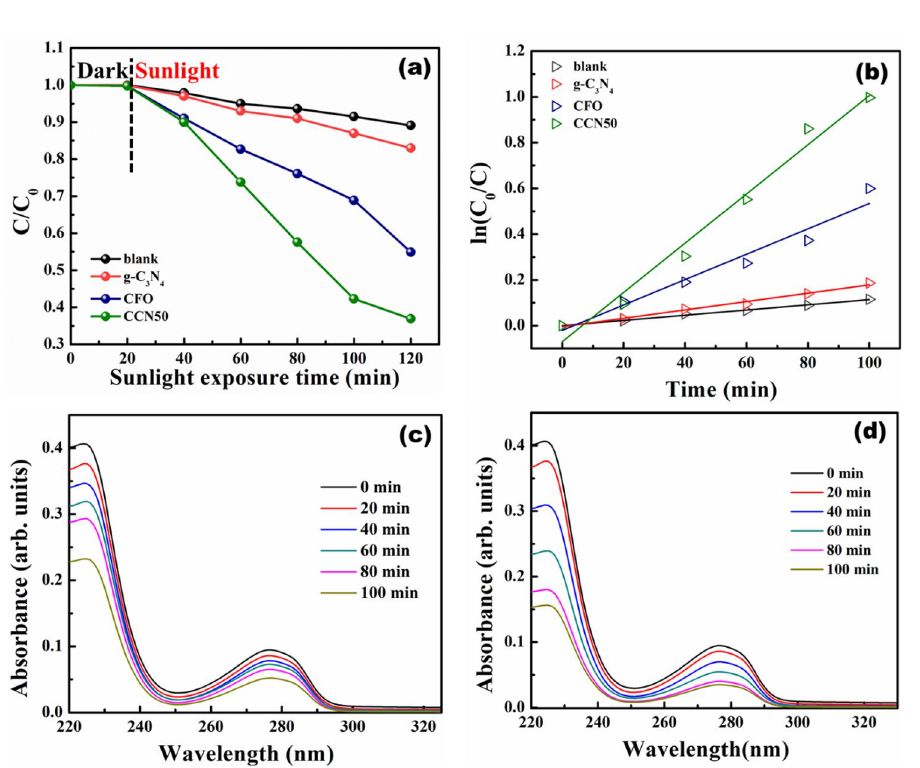
Figure 9. ( a ) Photocatalytic performance of CFO, g-C 3 N 4 , and CCN50 during degradation of BPA ( b ) corresponding reaction kinetics, and photodegradation profile of BPA using ( a ) CFO ( b )